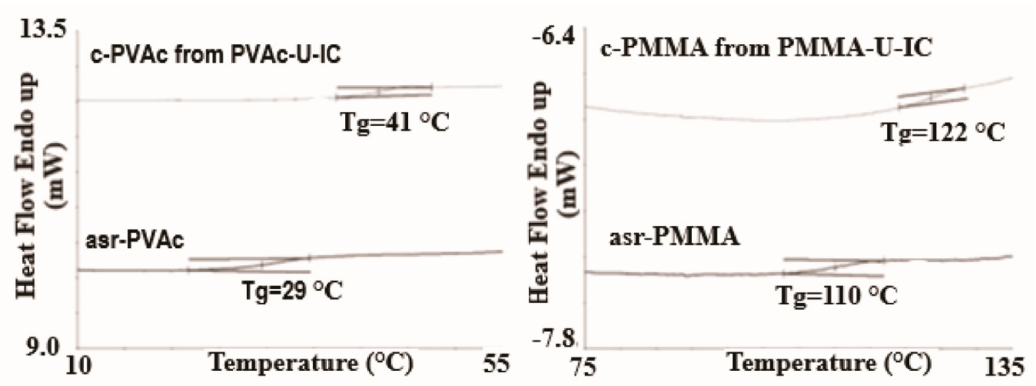
Figure 4. DSC observed glass transitions in amorphous poly (vinyl acetate)(PVAc) and Poly (Methyl methacrylate) (PMMA) as-received (asr) and coalesced (c) from their urea (U)-ICs. Reproduced with permission from [23]. Copyright 2013 Wiley Periodicals, Inc.